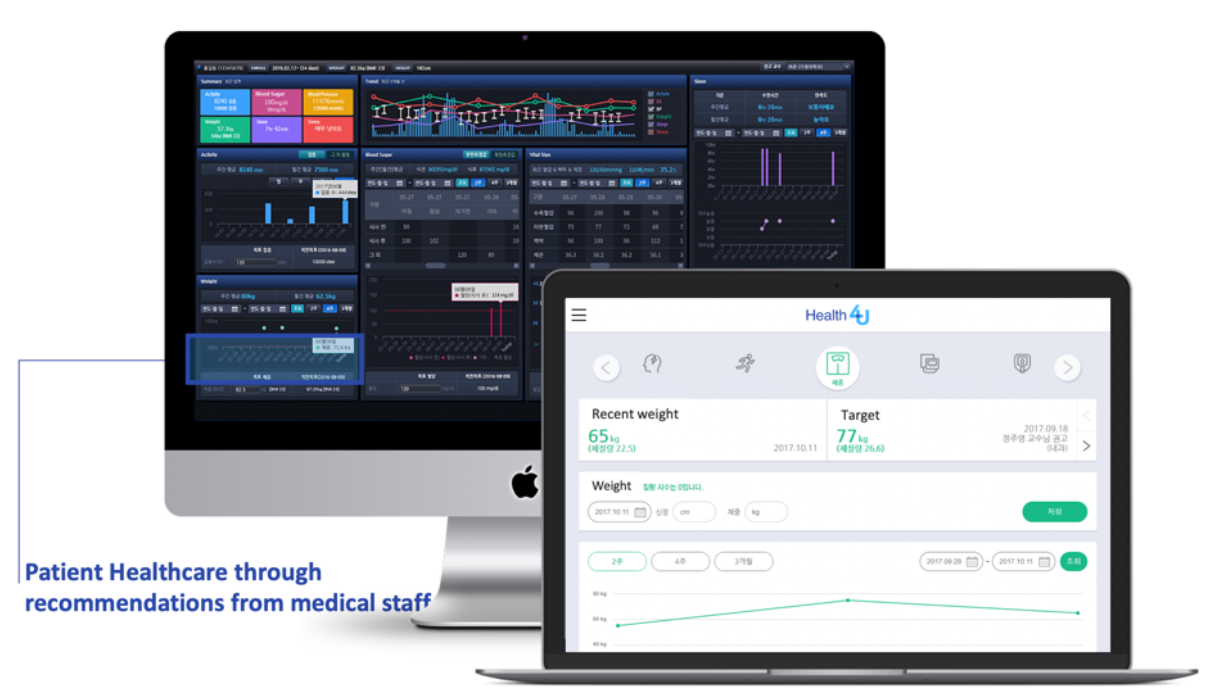
Figure 6. Dashboard for